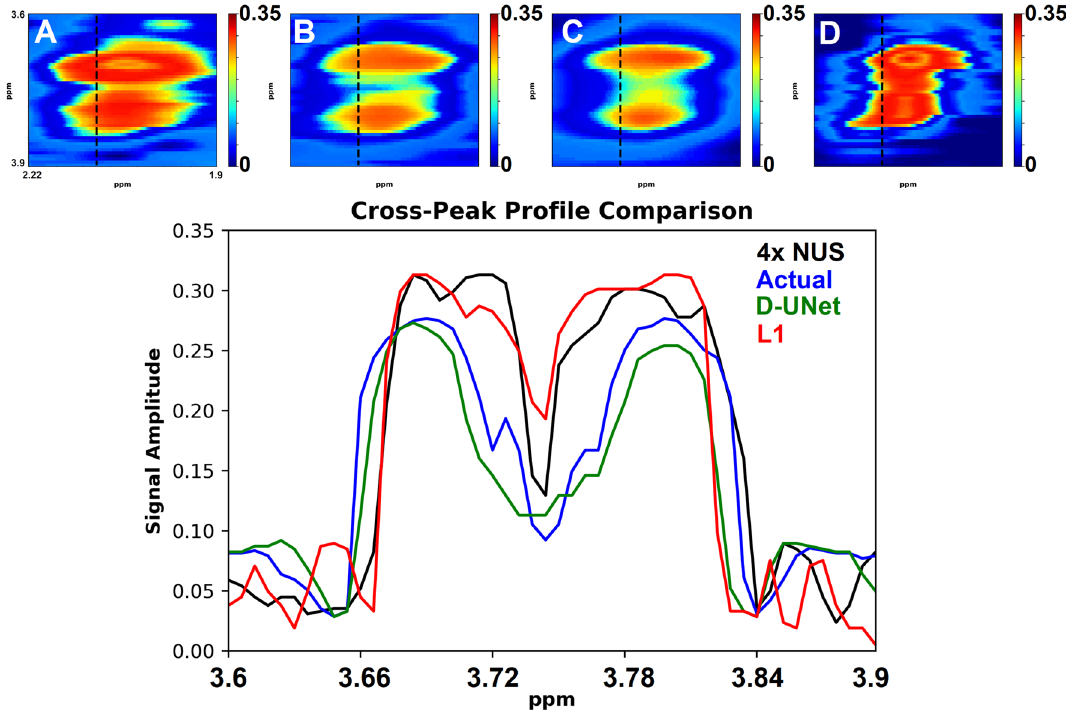
Figure 5. The cross-peak from F 2 = 3.6–3.9 ppm and F 1 = 1.9–2.22 ppm is displayed for the 4x NUS spectrum ( A ), the actual spectrum ( B ), the D-UNet reconstructed spectrum ( C ), and the ℓ 1 reconstructed spectrum ( D ). The profiles shown in the spectra are displayed and compare the cross-peak reconstruction.